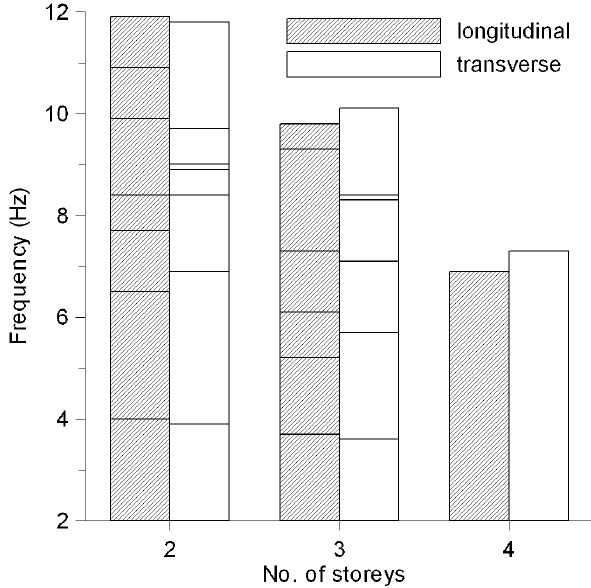
Fig. 9. Plot of building main frequency vs. height (no. of stories) for 14 examined buildings: 7 two-story, 6 three-story, and 1 four-story.